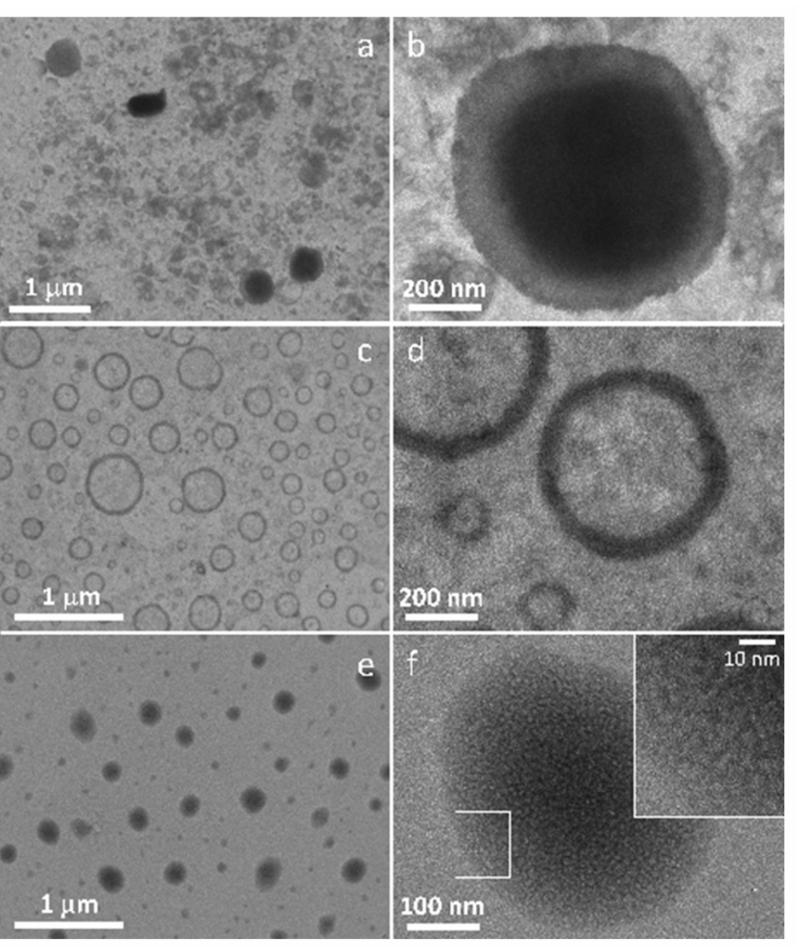
Figure 6. Transmission electron microscopy (TEM) images of: CT-NLC ( a , b ); N-NLC ( c , d ); L-NLC ( e , f ).